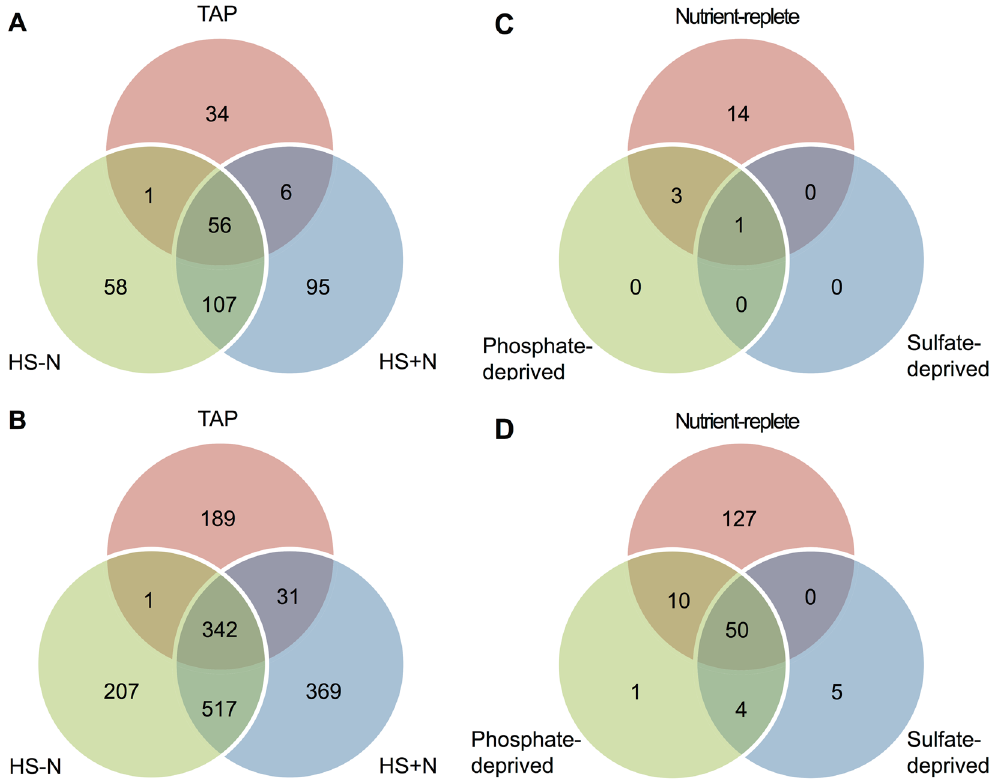
Figure 3. Comparison of predicted miRNA targets in Chlamydomonas cells grown under various nutritional deprivation conditions. Venn diagrams show the numbers of unique and shared putative miRNA targets in cells grown under the different trophic regimes. ( A ) and ( C ), Predicted cleavage targets. ( B ) and ( D ), Predicted translation repression targets. MicroRNA targets were computationally predicted (see Methods) based on the miRNAs identified from the AGO3-associated sRNA libraries in this study ( A and B ) and from the total sRNA libraries prepared by Chávez Montes et al . 25 ( C and D